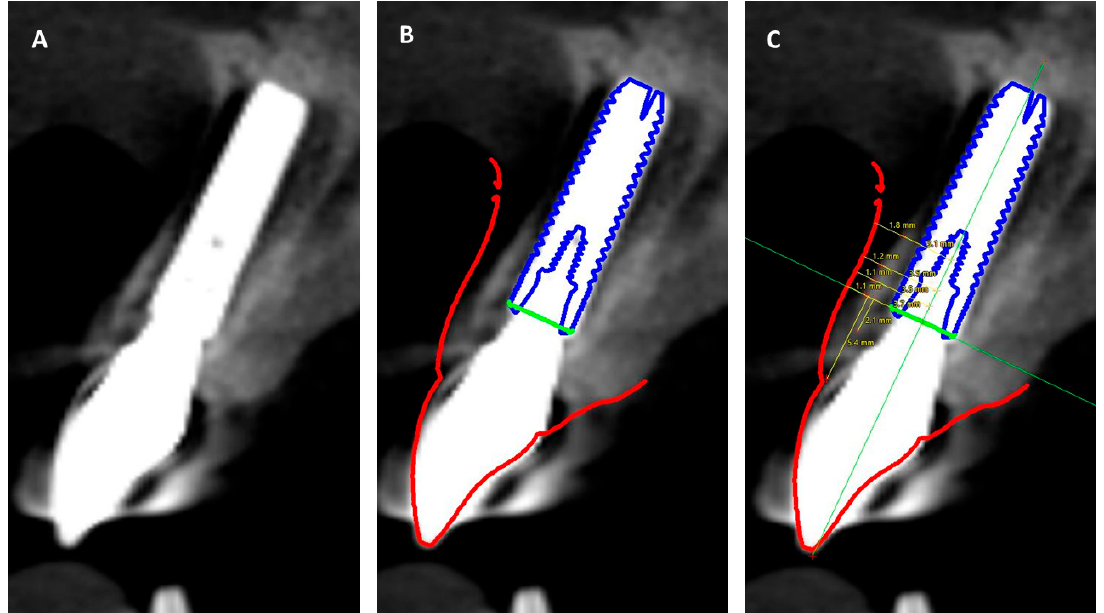
Figure 5. Implant in cross ‐ section view in coDiagnostiX software. ( A ) Cross ‐ section through the center of the implant, ( B ) Implant avatar and soft tissue silhouette superimposed on the implant, ( C ) Vertical and horizontal measurements made using annotation lines to evaluate the thickness and height of soft and hard tissues.